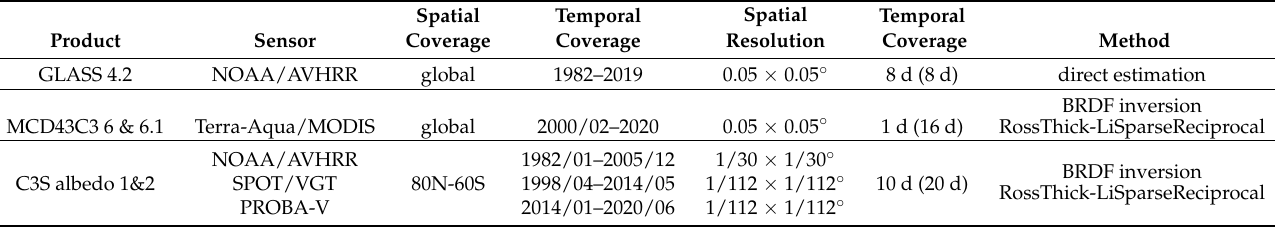
Table 1. Summary of the satellite products